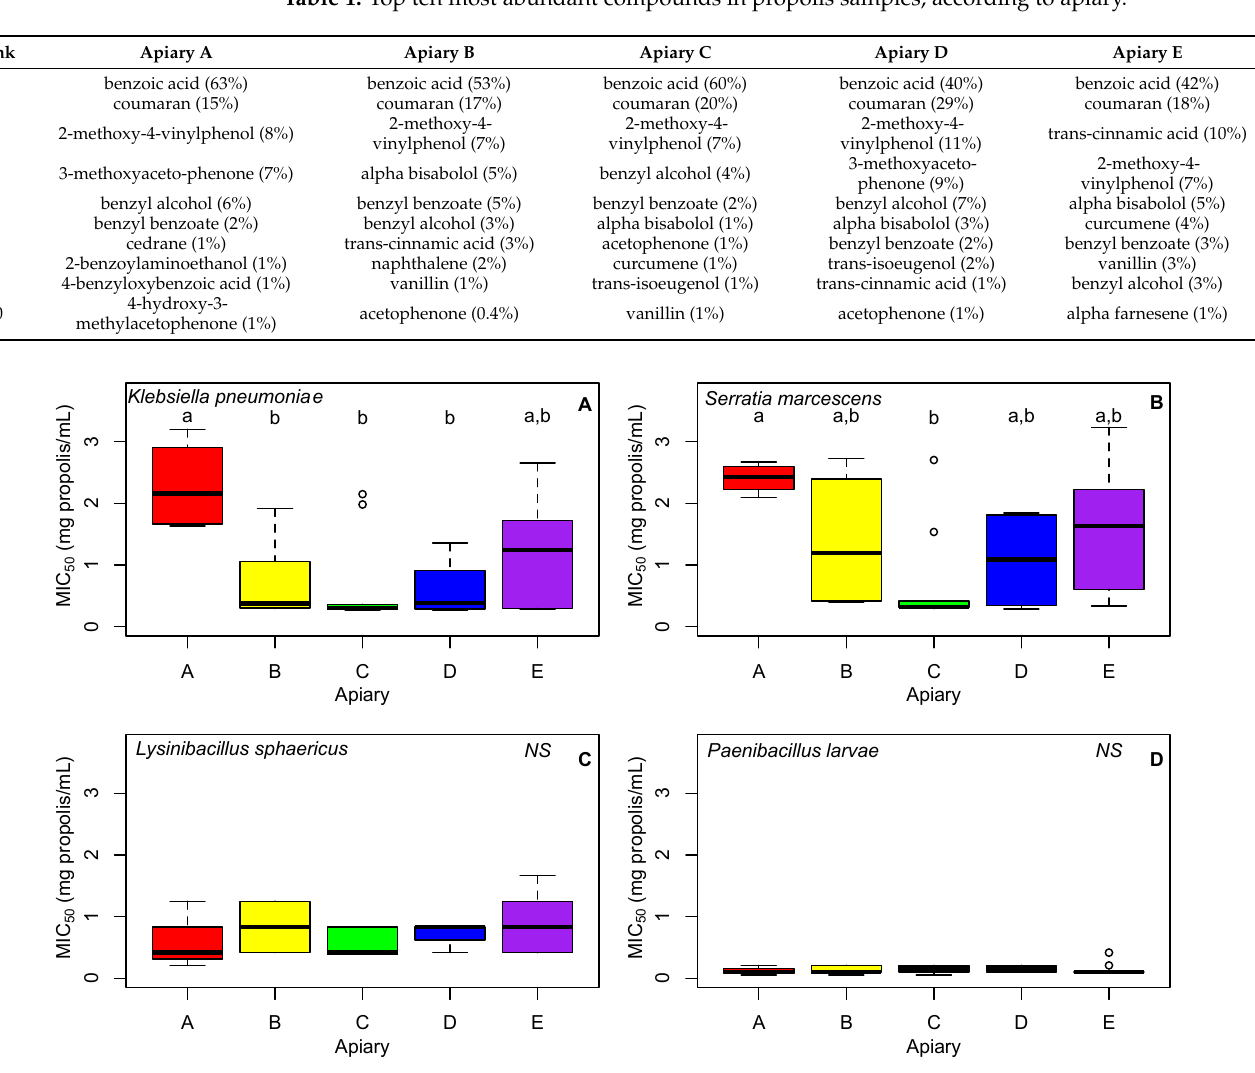
Figure 2. Principal components plot of compound variation among propolis samples (main figure), Table 1. Top ten most abundant compounds in propolis samples, according to apiary.